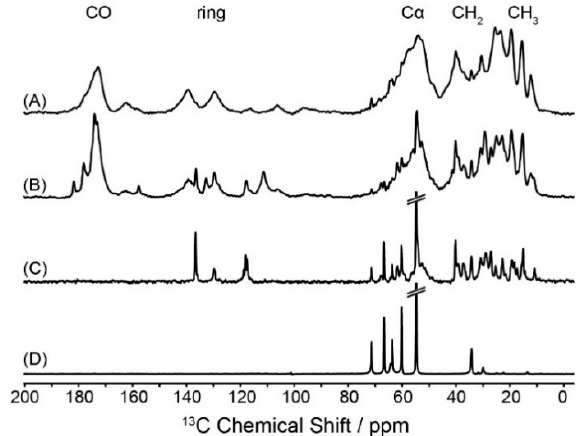
Figure 2. Proton-decoupled 13 C magic-angle spinning (MAS) NMR spectra of U- 13 C-Y1R reconstituted in DMPC- d 54 membranes using different polarization schemes. ( A ) 13 C CPMAS NMR spectrum using a CP contact time of 700 μ s. ( B ) Directly excited 13 C MAS NMR spectrum. ( C ) 13 C INEPT NMR spectrum and ( D ) 13 C INEPT NMR spectrum of DMPC- d 54 membranes in the absence of Y1R. All NMR spectra were acquired at 30 °C at a MAS frequency of 7 kHz.